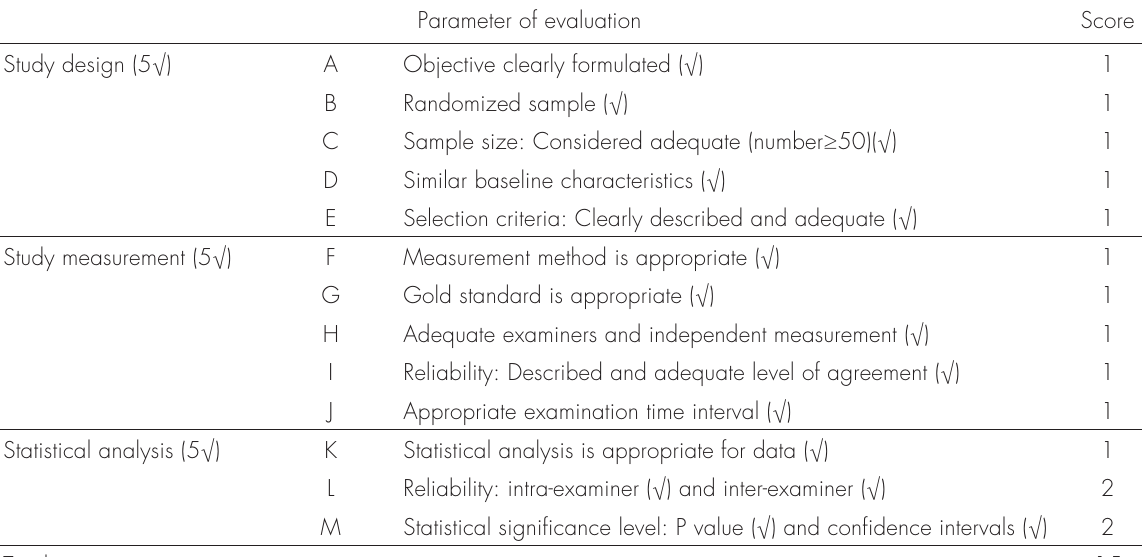
Table II. The QUAMAS (Quality Assessment of Measurement Accuracy Studies) tool used in the study.